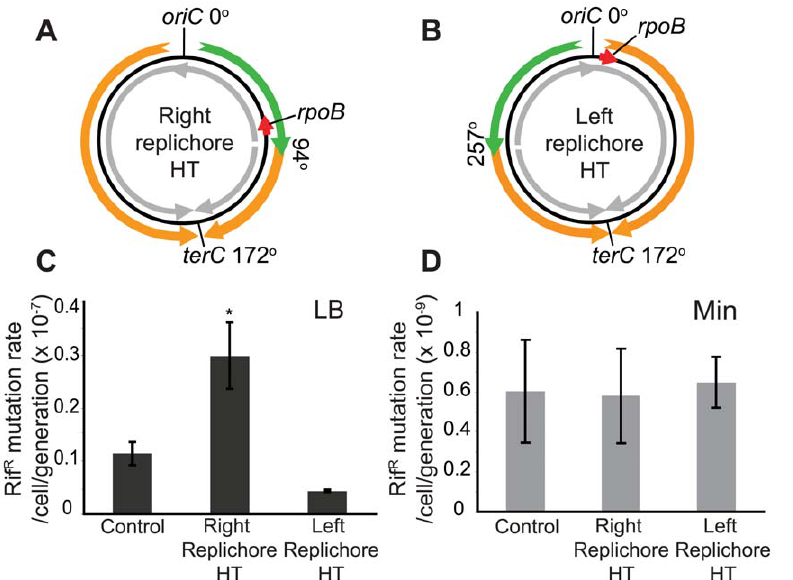
Figure 4. Increased mutation rate of a gene within the inversion in the HT strain. (A,B) Schematic diagrams of chromosomes (black circles) with inversion of K of either the right (A) or the left (B) replichore, resulting in head-on transcription (HT) within the inversion. Orange and green arrows: replication co-directional and head-on to transcription, respectively; grey arrows: predominant direction of transcription. Mutations conferring resistance to rifampicin (rif R ) map to the rpoB gene (red arrow) which is transcribed co-directional to replication in the wild type and left replichore HT strains, but transcribed head-on in the right replichore HT strain. (C) Spontaneous rif R mutation rates as measured by fluctuation tests in LB (dark grey bars) in the control, right and left replichore HT strains. *: rif R rate in the right replichore inversion strain is significantly different from control (P , 0.05). (D) Rif R mutation rates in Min (light grey bars).